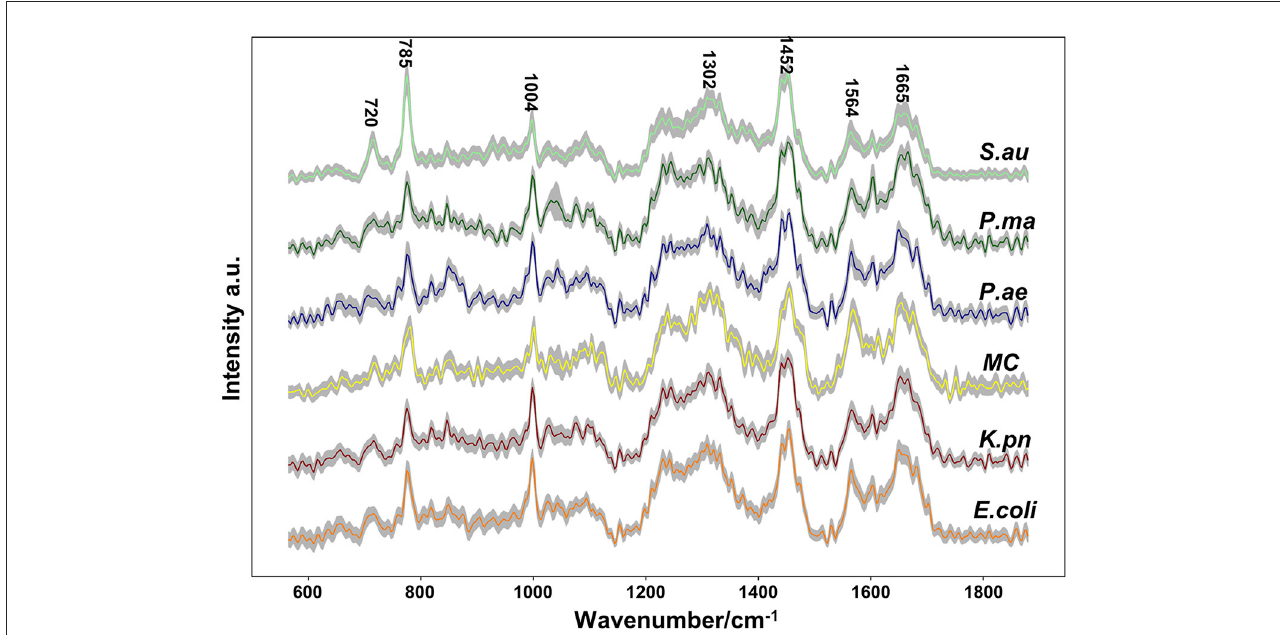
TABLE 1 Raman bands in the spectra of childhood respiratory pathogens and their tentative